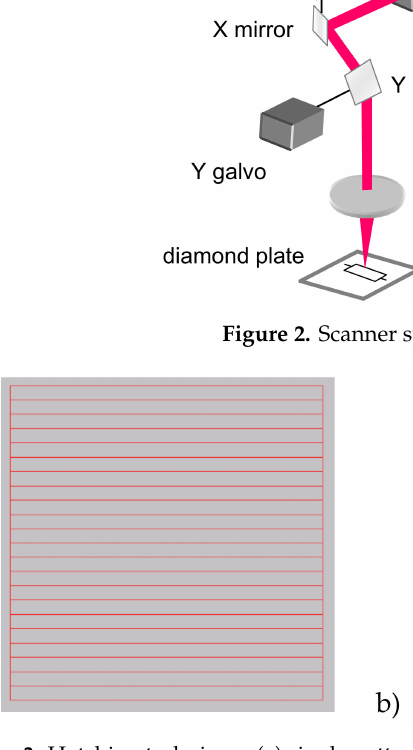
Figure 3. Hatching technique: ( a ) single pattern; ( b ) double-pattern (0 o and 90 o